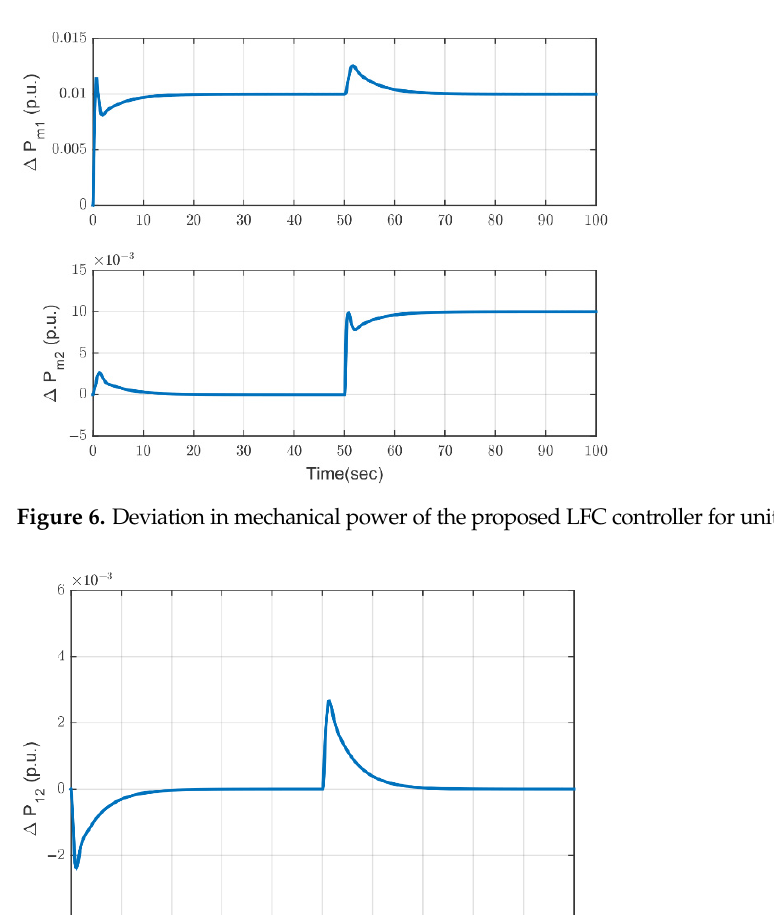
Figure 5. Frequency deviations in the proposed LFC scheme during unit step load disturbance.